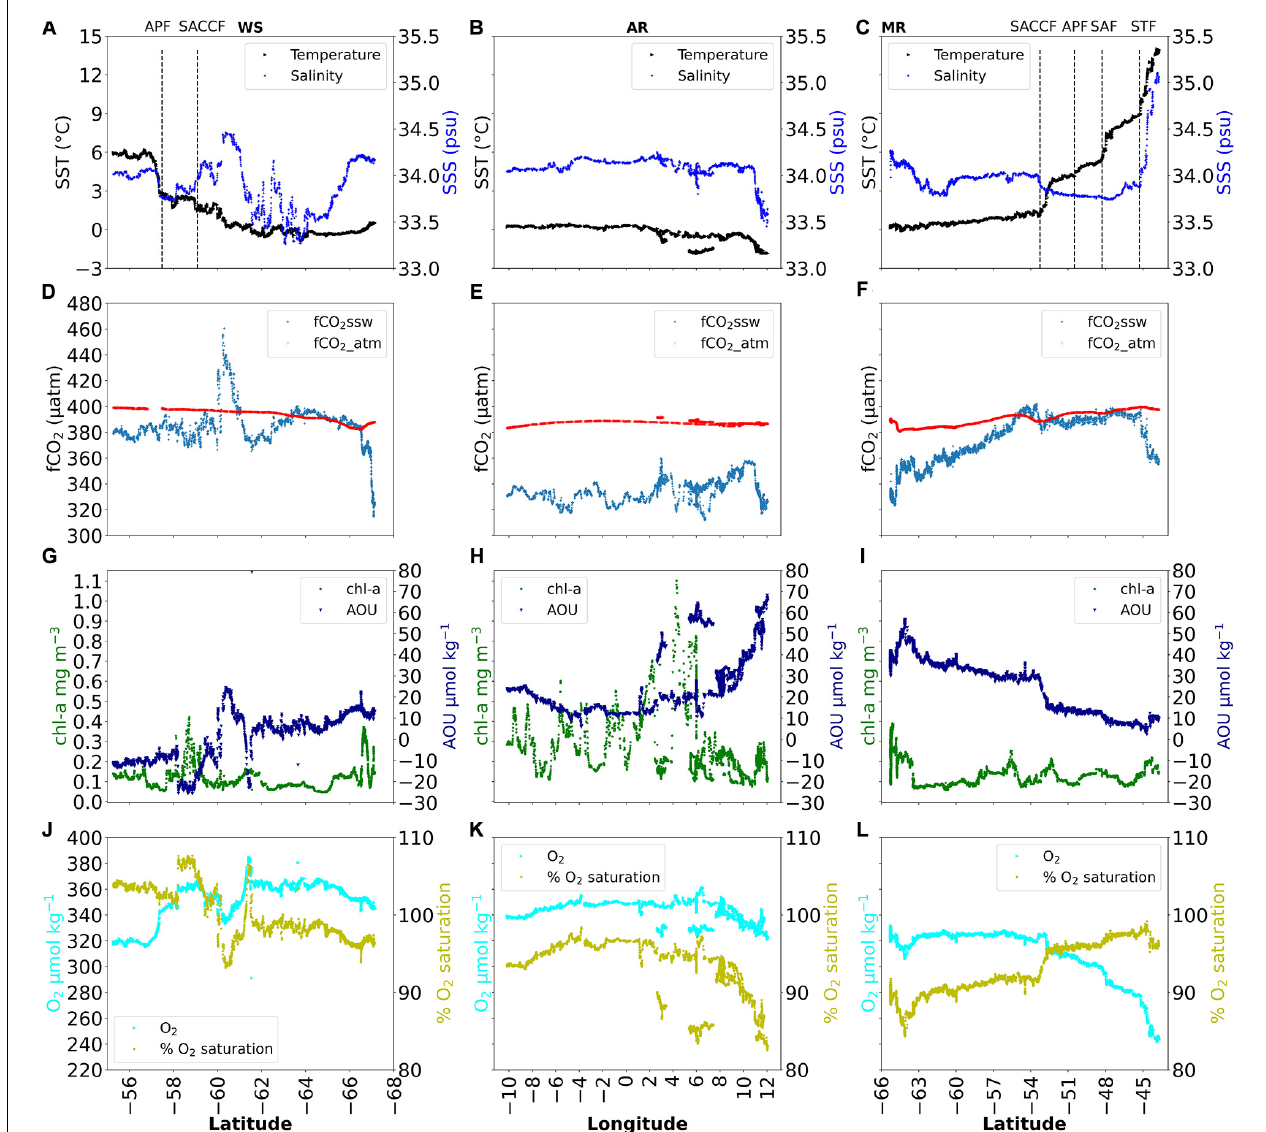
FIGURE 3 | Spatial distributions of sea surface fugacity of CO 2 with physical and biological parameters. Column 1: (A,D,G,J) WS region, Column 2: (B,E,H,K) AR region, and Column 3: (C,F,I,L) MR region. The red color represents the distributions of the atmospheric fugacity of CO 2 in each of the defined